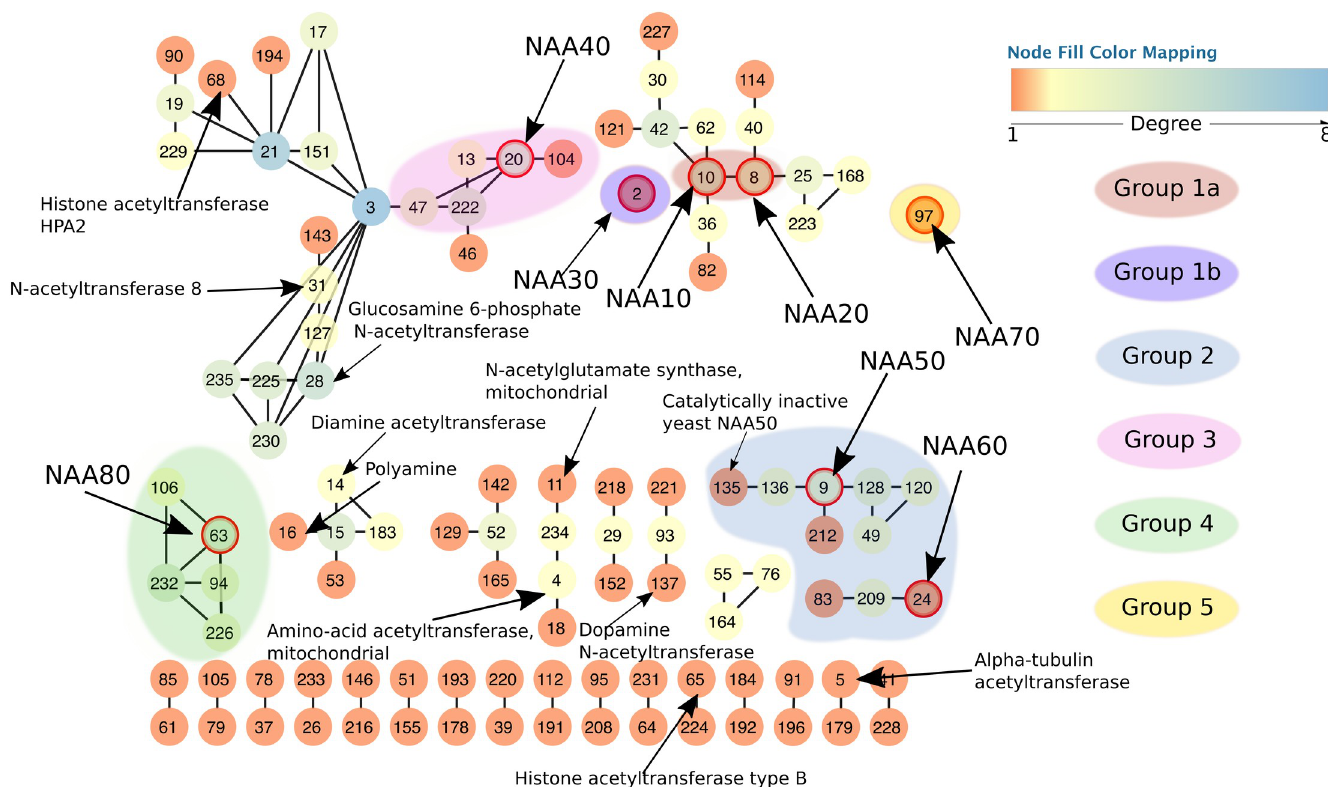
Fig 2. Simplified view of the resulting sequence similarity network. Each node represents one cluster from the original network. Edges connect two nodes in the simplified network if there is at least one edge between any nodes of the corresponding clusters in the full network. Node colors correspond to their degree, i.e. the number of connections to the neighboring nodes. Each node in the network has a unique number assigned by clusterONE [72]. The numbers serve as cluster names in cases where the cluster is uncharacterized. All nodes circled in red are known and experimentally confirmed N-terminal acetyltransferases (10 –NAA10, 8 –NAA20, 2